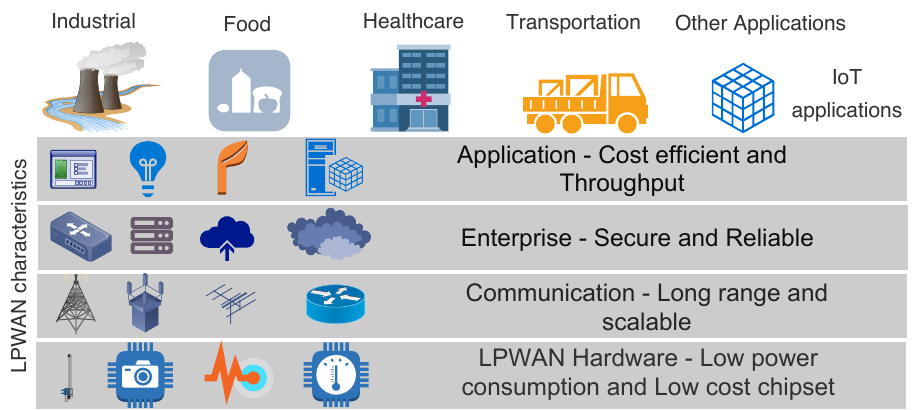
Figure 1. LPWAN characteristics that makes it an excellent choice for the IoT